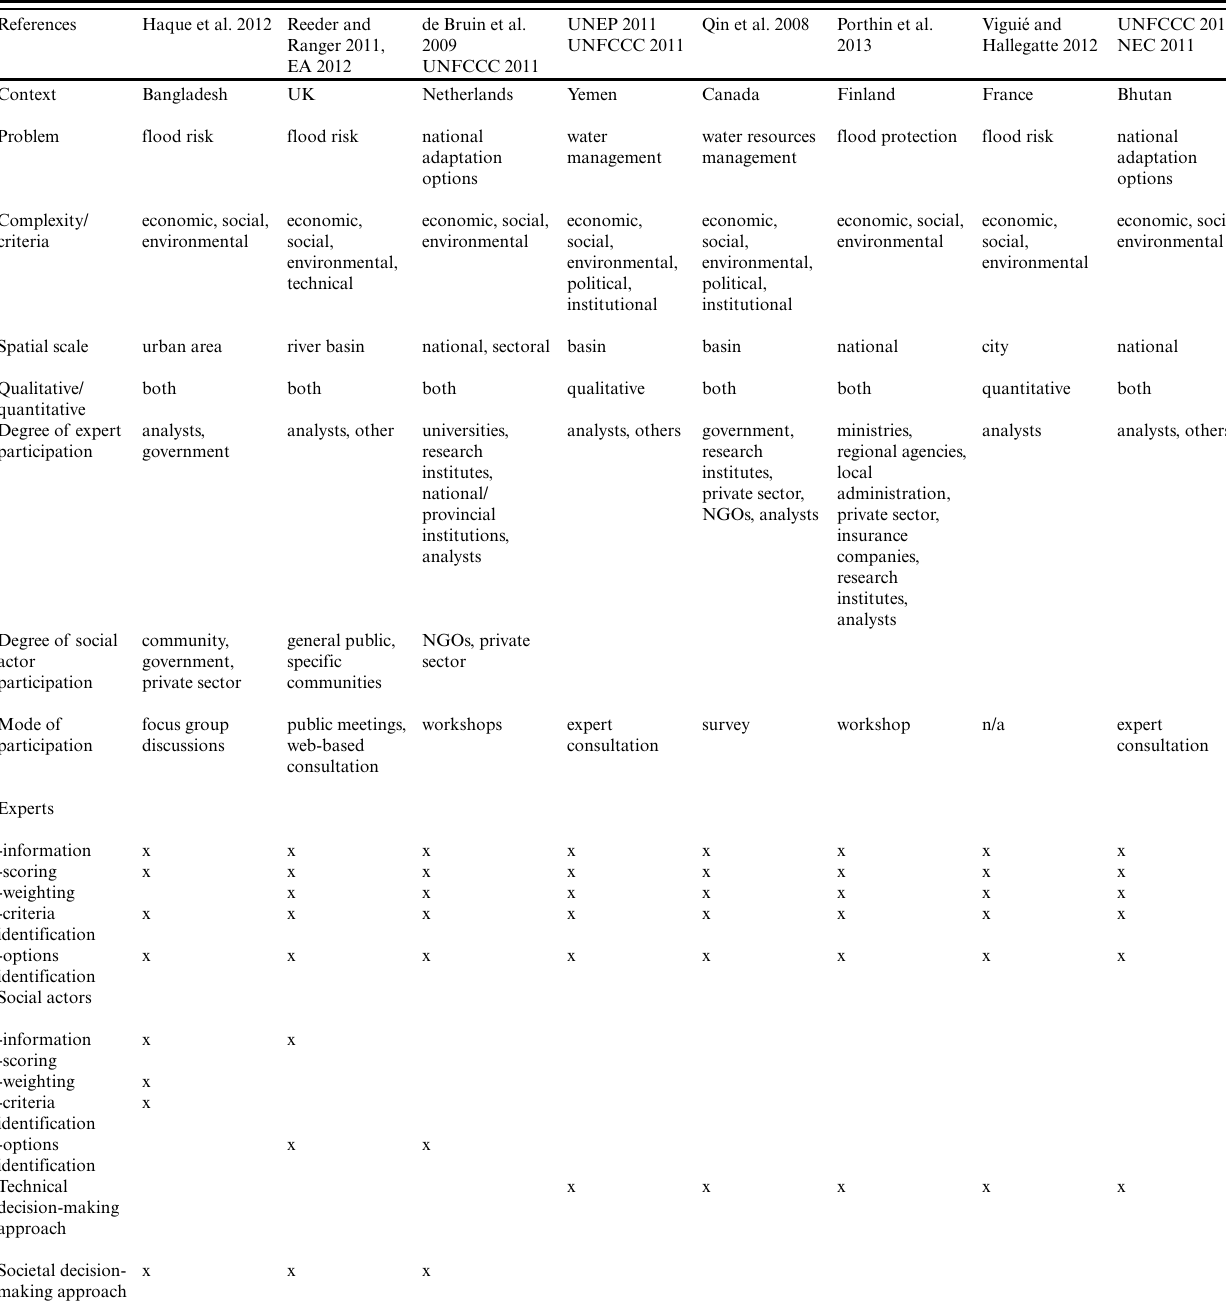
Table 2 . Complexity and degrees of participation in multicriteria methods applied to the prioritization of climate adaptation